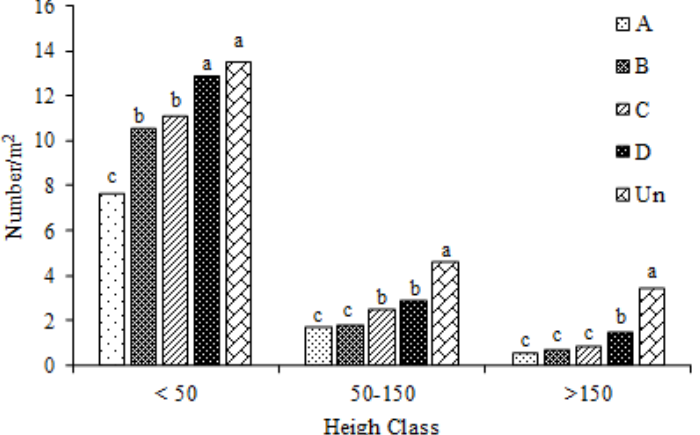
Figure 5. The number of seedlings per square meter for height classes <50 ( n = 1352), 50–150 ( n = 233) and >150 cm ( n = 146). A, B, C, D and Un represent skid trail with a period of 0–5 years, 6–10 years, 11–15 years, 16–20 years and Undisturbed area, respectively . Different letters in a row indicate significant differences among seedlings class ( p < 0.05) based on Duncan’s multiple range tests.